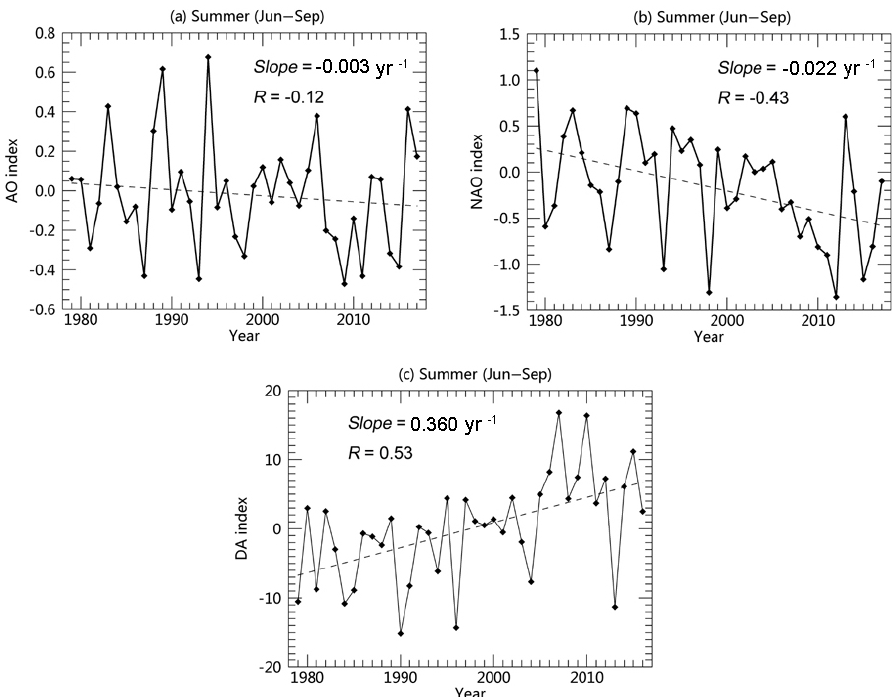
Figure 13. Variations in and trends of the mean atmospheric indices in summer (June–September), including (a) the AO, (b) the NAO, and (c) the DA index. The linear trends of NAO and DA indices are both significant at the 95% significance levels according to the t -test method, while the AO index reveals an insignificant trend. Table 4. Correlations between summer mean atmospheric index and sea ice minimum area in the PA sector for the different decades and the whole 38-year period.